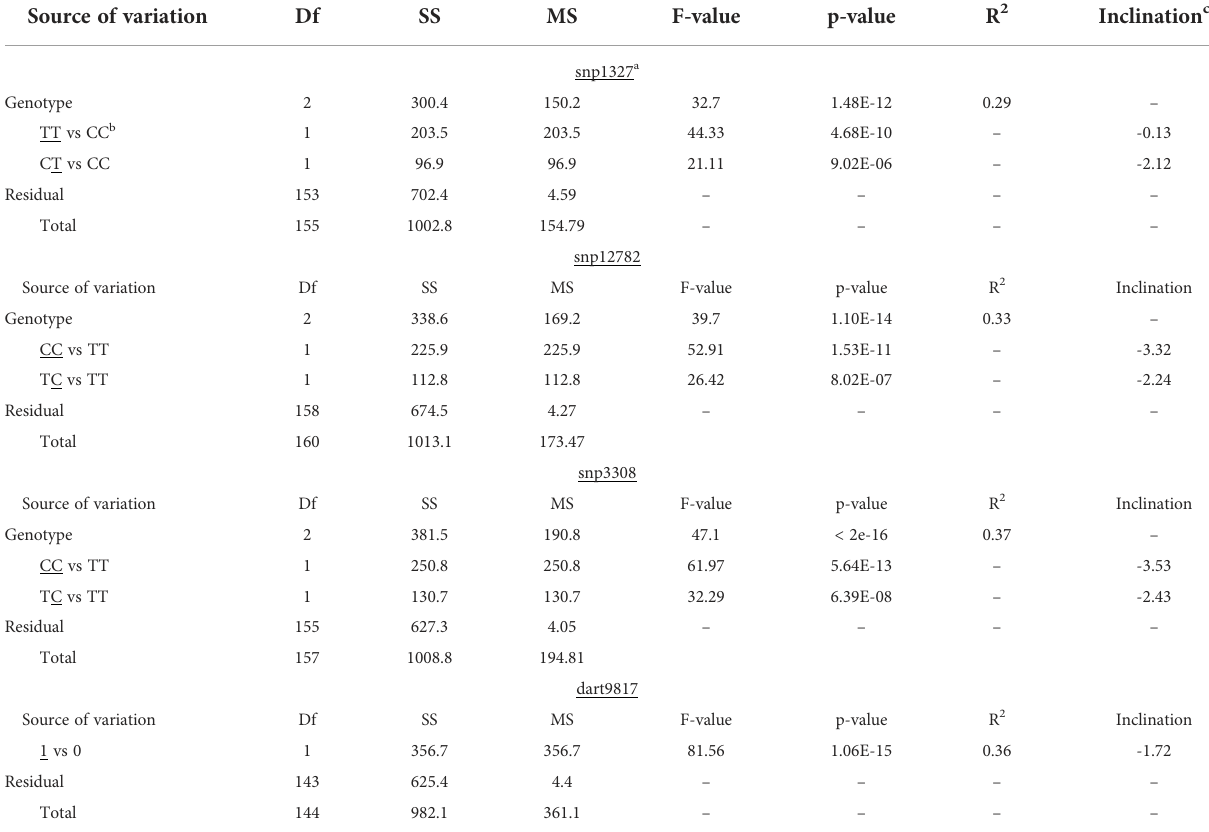
TABLE 3 Simple linear regression analysis between molecular markers (snp1327, snp12782, snp3308 and dart9817) fl anking the genomic region of the major locus Co-Realce and the phenotype of F 2 (BRSMG Realce × BRS FC104) plants inoculated with the C. lindemuthianum race 475. Source of